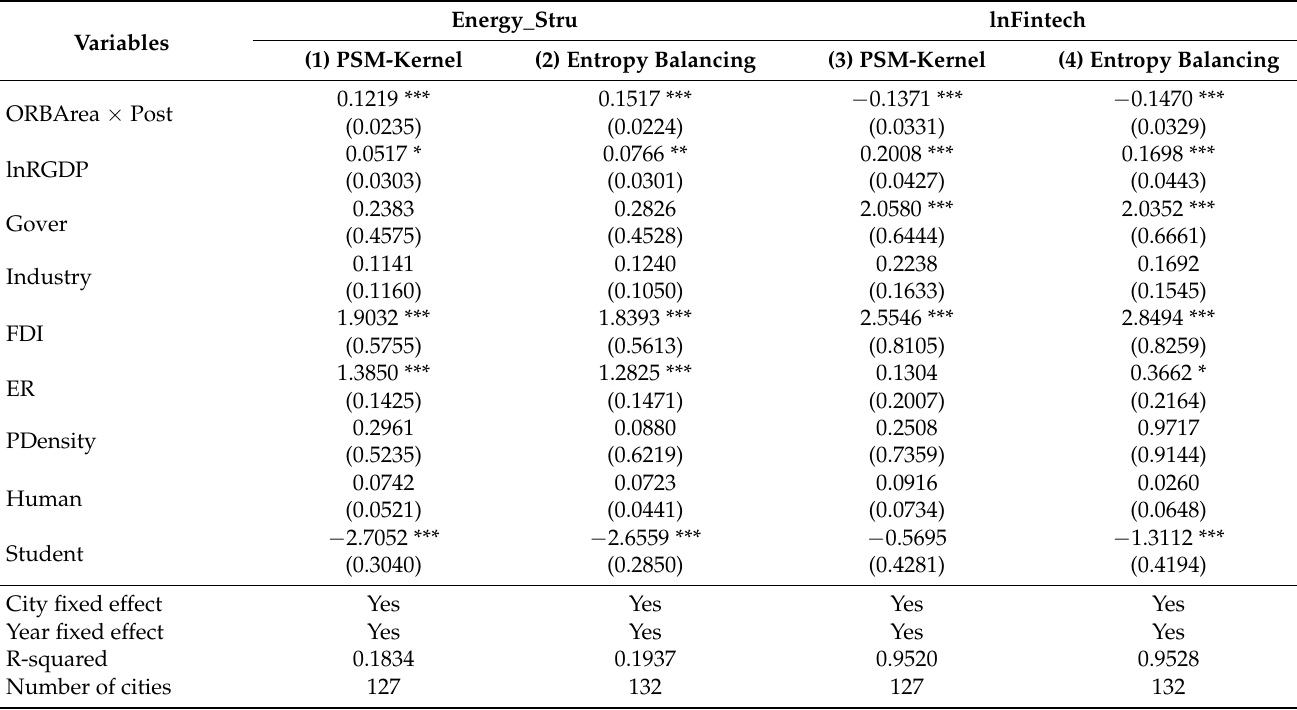
Table 8. Empirical results of the industrial structure